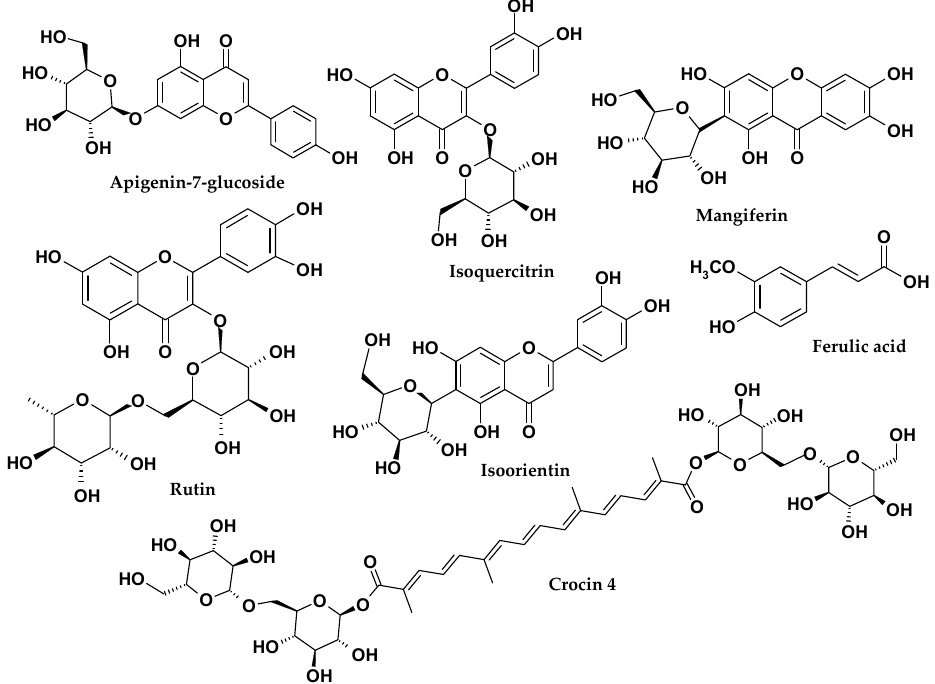
Figure 6. Chemical structure of selected quality markers and some major compounds of C. sativus perianth.